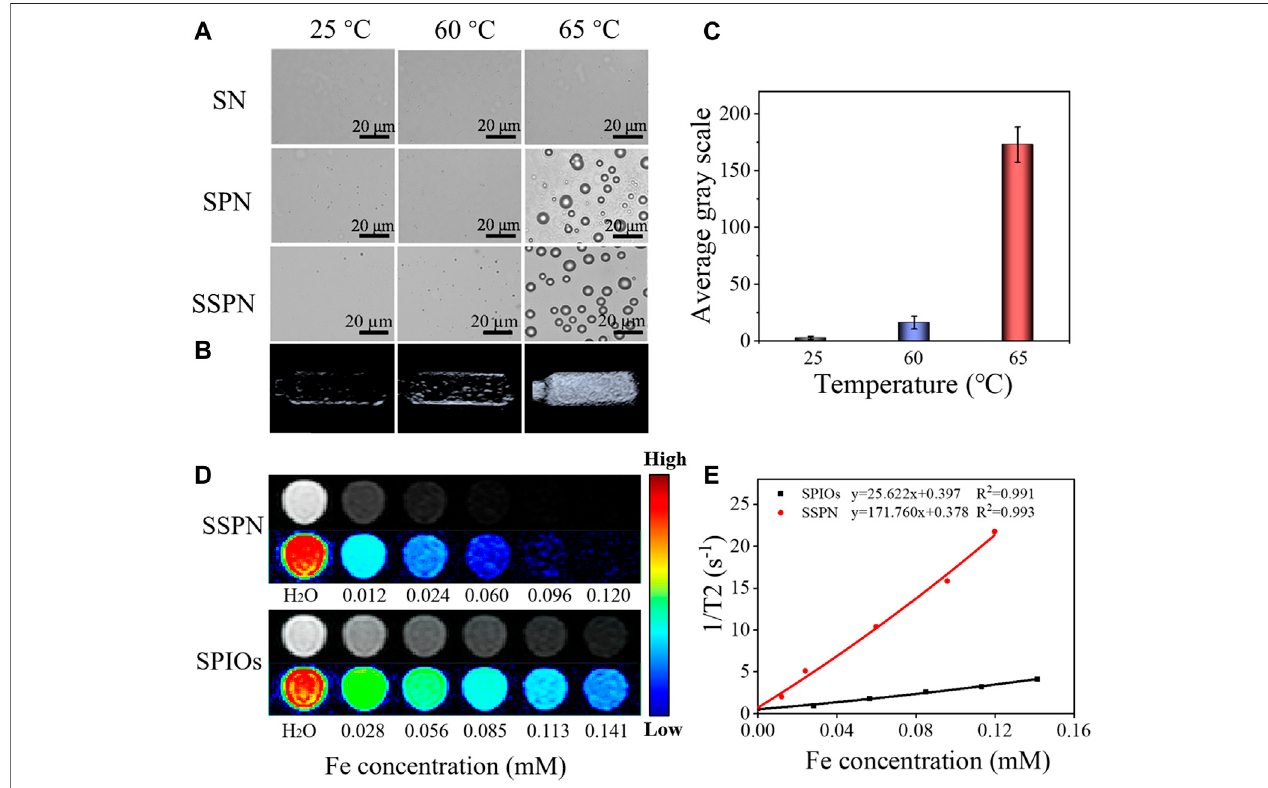
FIGURE 3 | (A) Polarizing microscope images of SNs, SPNs, and SSPNs before and after being heated from 25 ° C to 65 ° C (scale bar = 20 μ m). (B) In vitro US imagesofSSPNsat25 ° C,60 ° C,and65 ° Cand (C) averagegrayvaluesofSSPNs( n =3). (D) T2-weightedMRimagesofSSPNsandSPIOsatdifferentFeconcentrations using a 1.5-T MRI scanner. (E) T2 relaxation rates of SSPNs and SPIOs corresponding to (D)